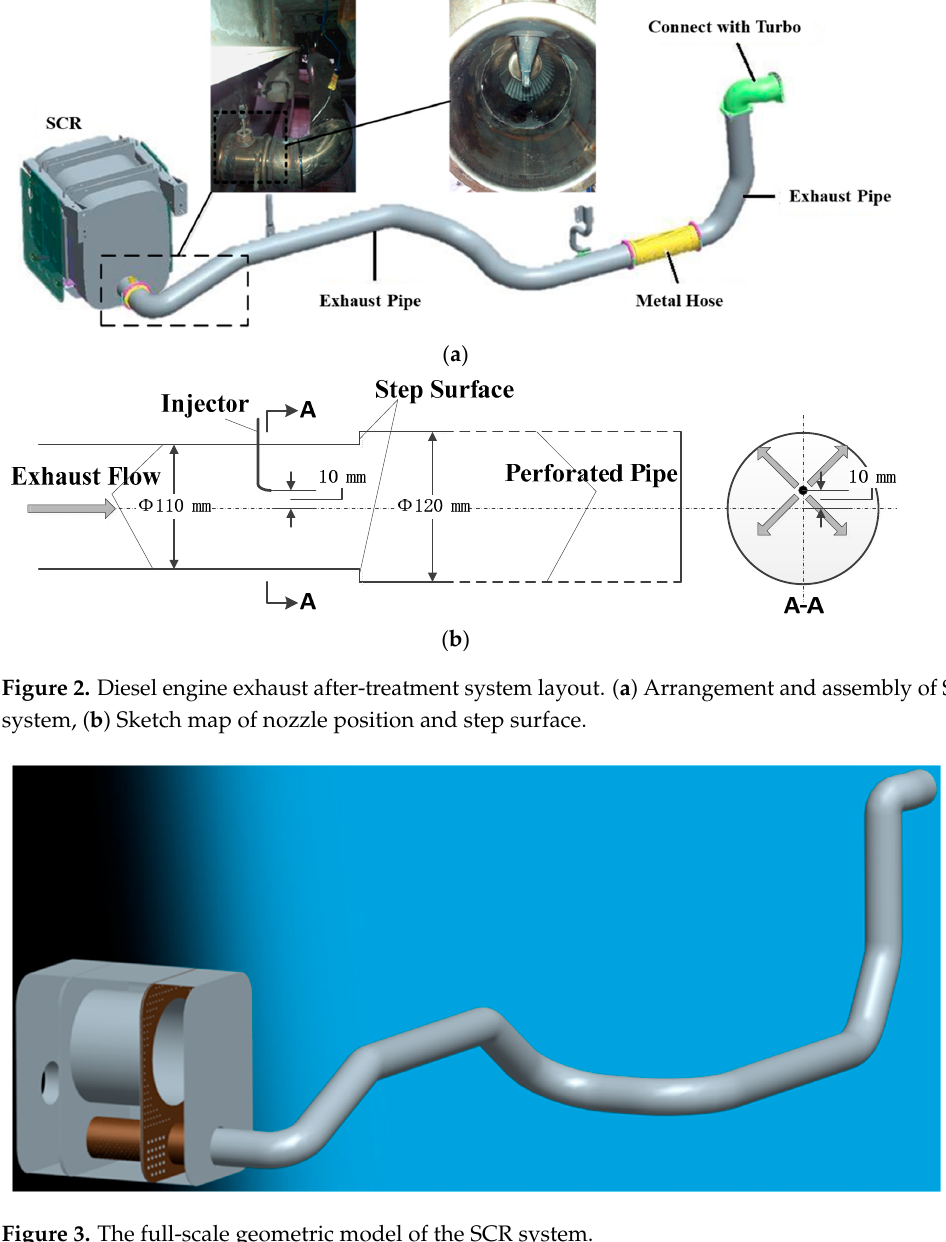
Figure 3. The full-scale geometric model of the SCR system.